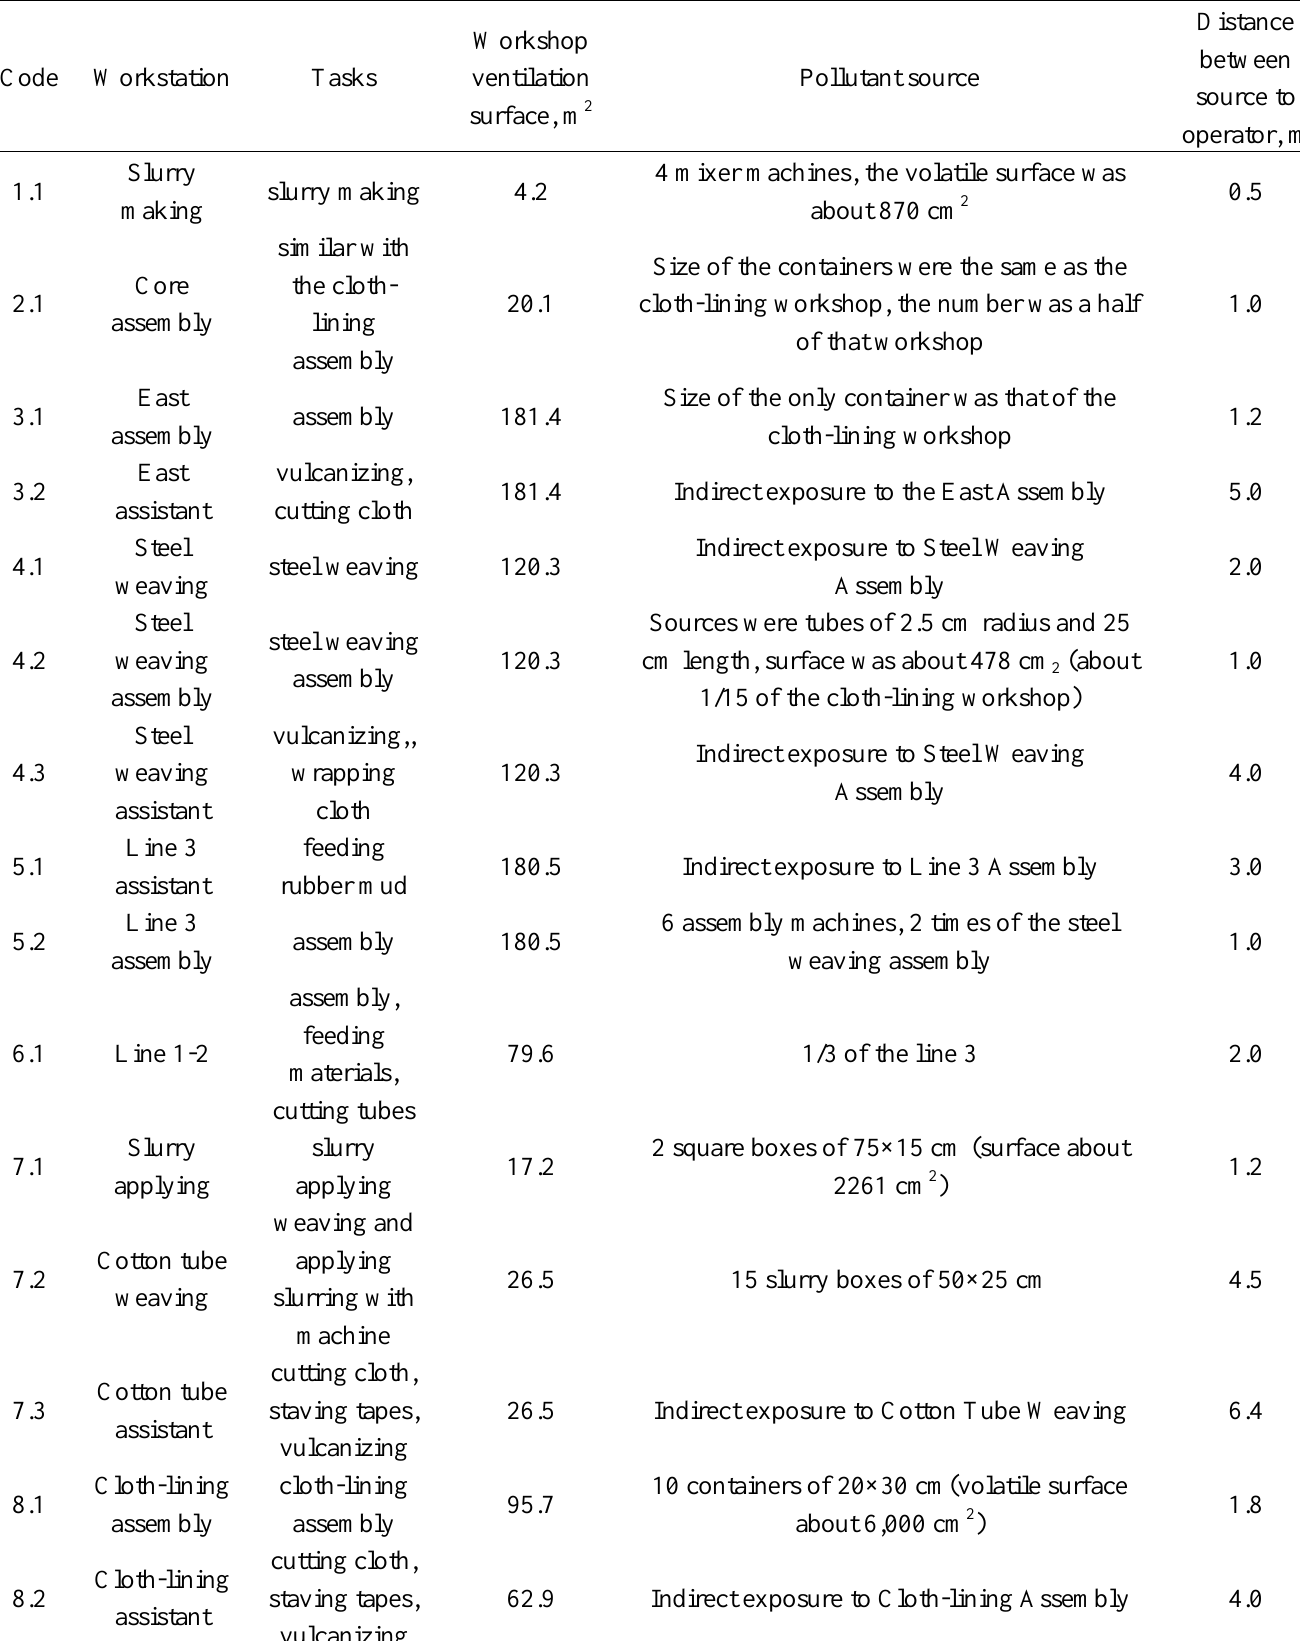
Table 2. Information for experts to estimate